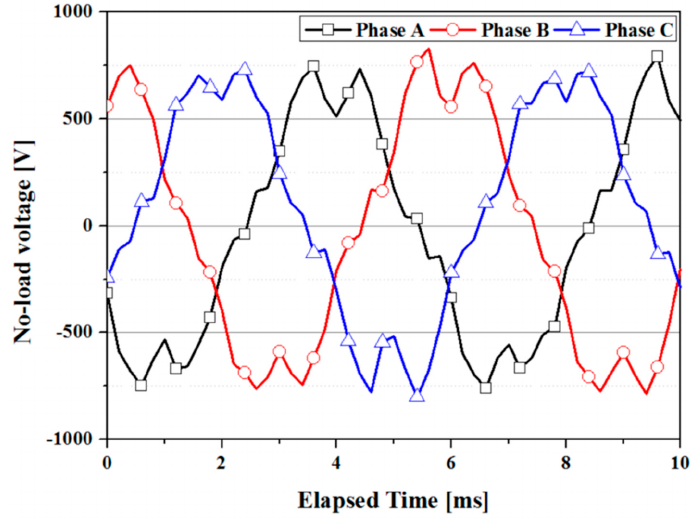
Figure 15. No-load voltage due only to the NI HTS field coil.